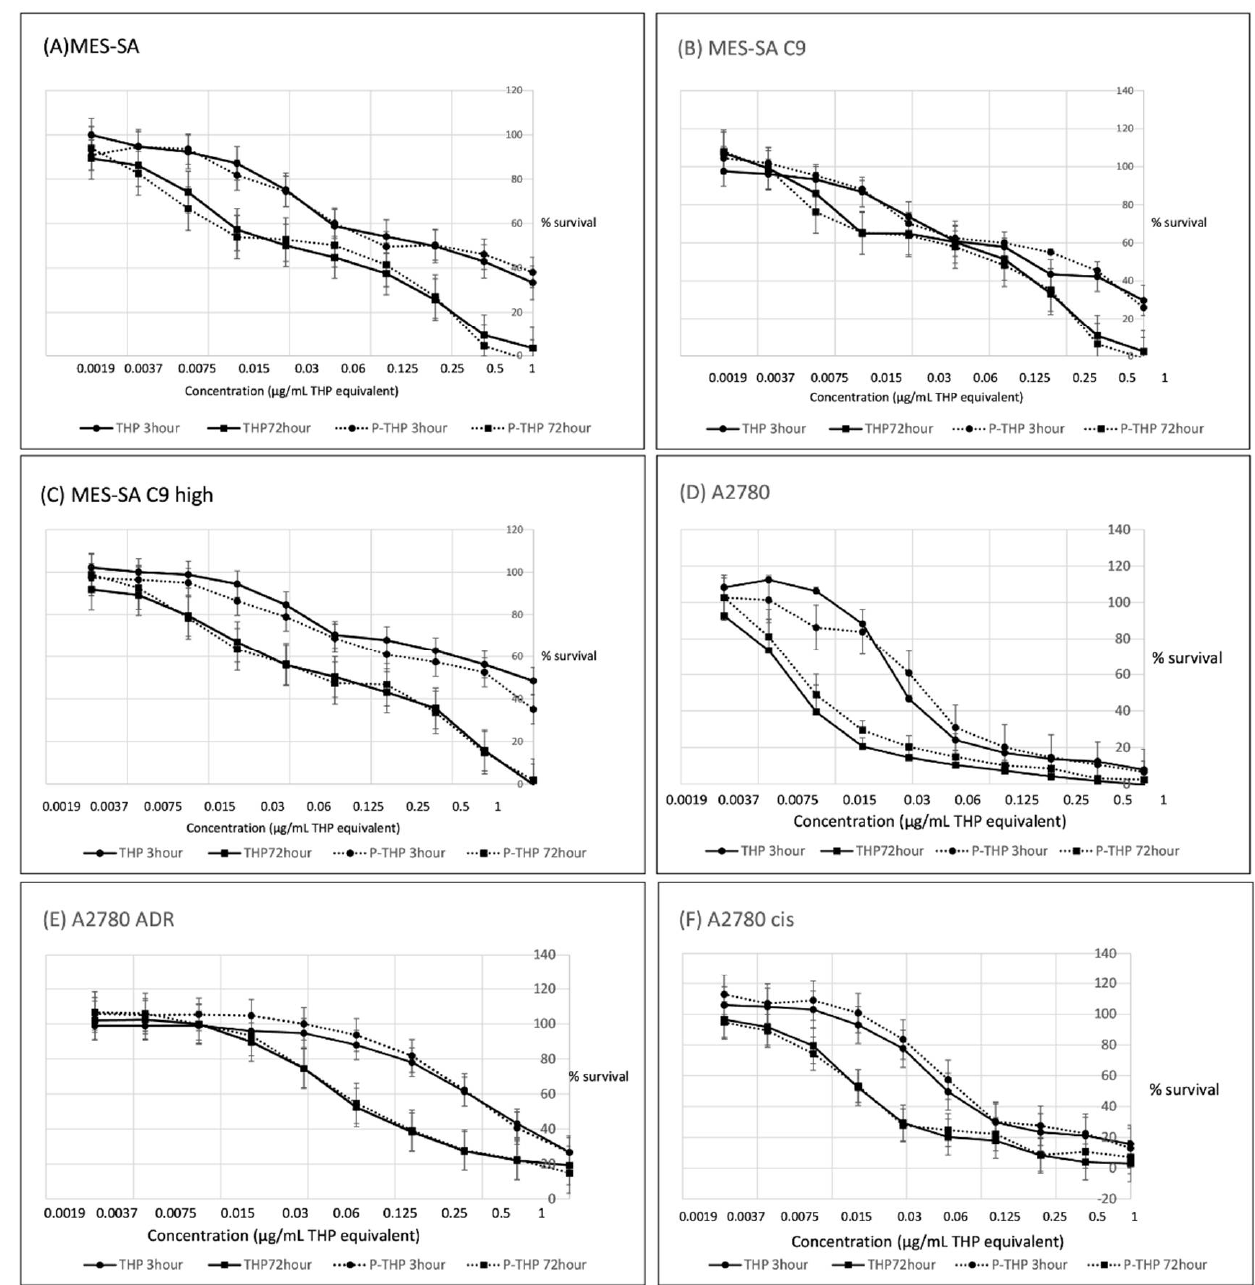
Figure 1. Cytotoxicity of THP or PTH for MES-SA ( A ), MES-SA C9 ( B ), MES-SA C9 high ( C ), A2780 ( D ), A2780/ADR ( E ), and A2780/cis ( F ) were assessed. Dose-dependent toxicity of P-THP, similarly to THP, were identified at both 3 h and 72 h incubation. Data are expressed as a mean percentage of control growth ± standard deviation (SD) ( n = 8 replicates per concentration) .